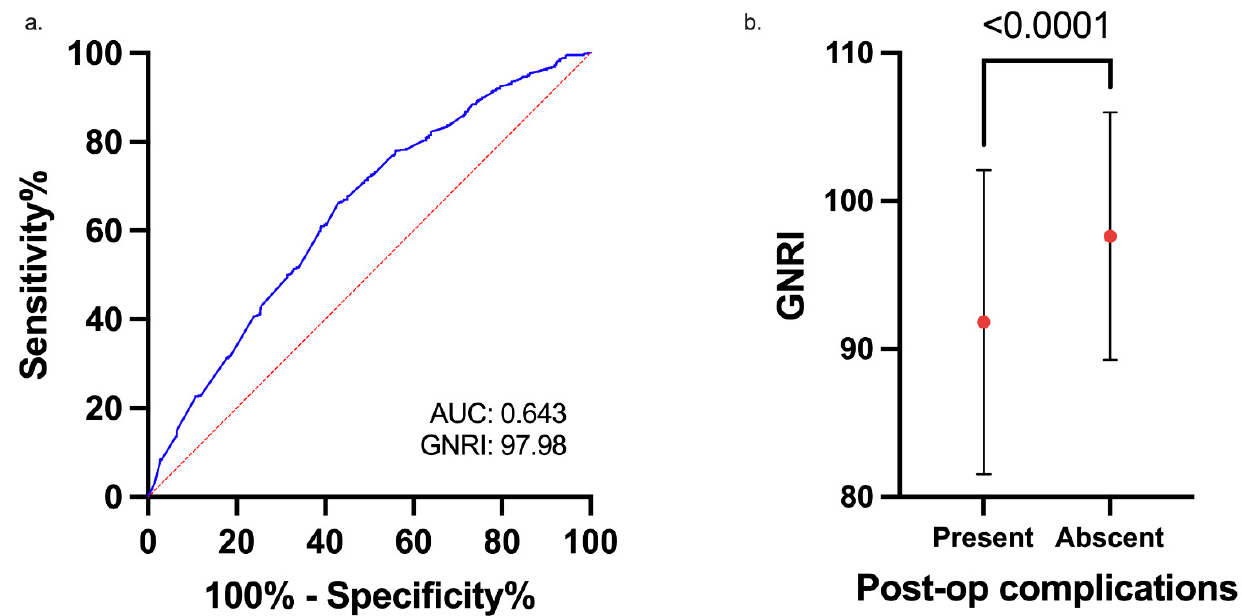
Figure 2. ( a ). Receiver operating characteristic (ROC) curve analysis of the geriatric nutritional risk index (GNRI) for overall survival (OS) in elderly patients with colorectal cancer (CRC). ( b ). The mean GNRI in patients with or without Clavien-Dindo grade ≥ 2 postoperative complications. Table 2. The association of GNRI and clinicopathological factors in 1206 patients with CRC undergoing curative resection.